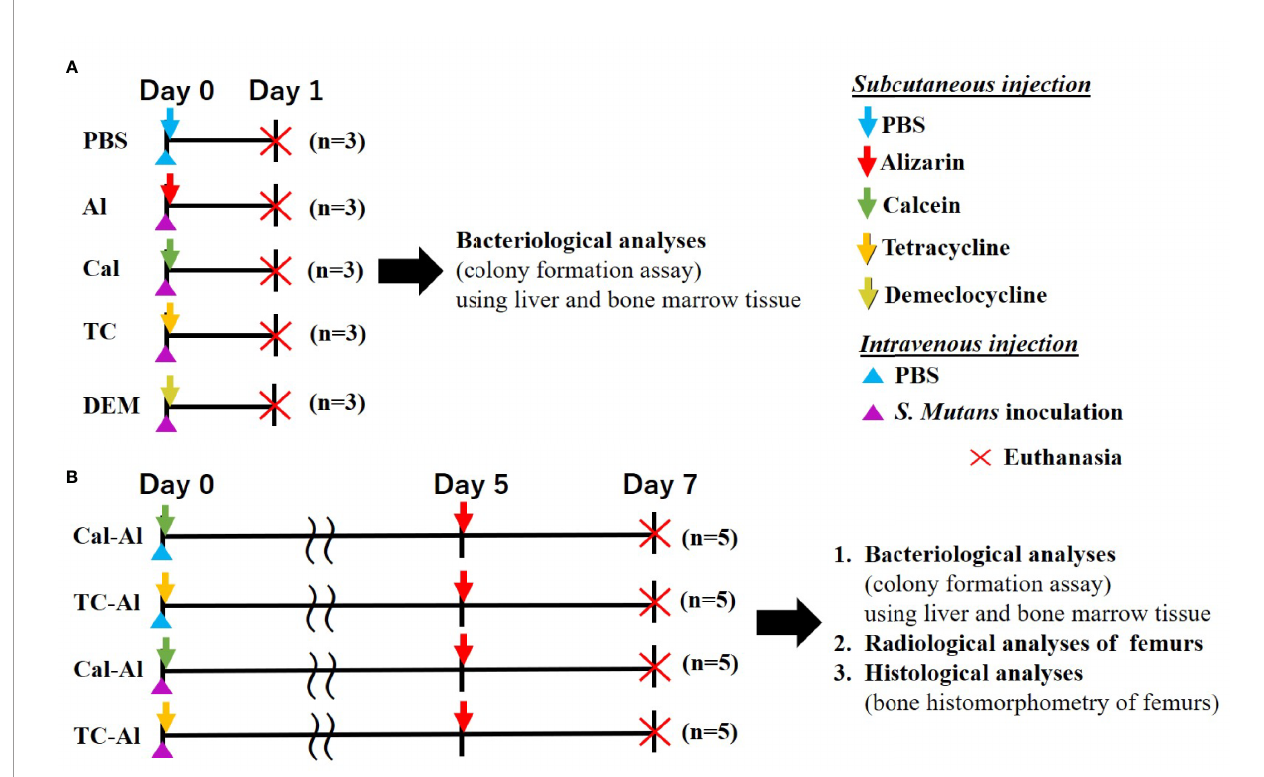
FIGURE 1 | Experimental design. (A) One-day experiment comparing the effects of 4 different fl uorescent reagents on bacterial colony formation in S. mutans - infected mice. Subcutaneous injection of PBS to the intravenously injected mice used as a control (B) Seven-day experiment examining the effects of tetracycline versus calcein as a fl uorescent reagent bacteriologically, radiologically, and histologically in the S. mutans- infected model comparing to the mice received an intravenous injection of